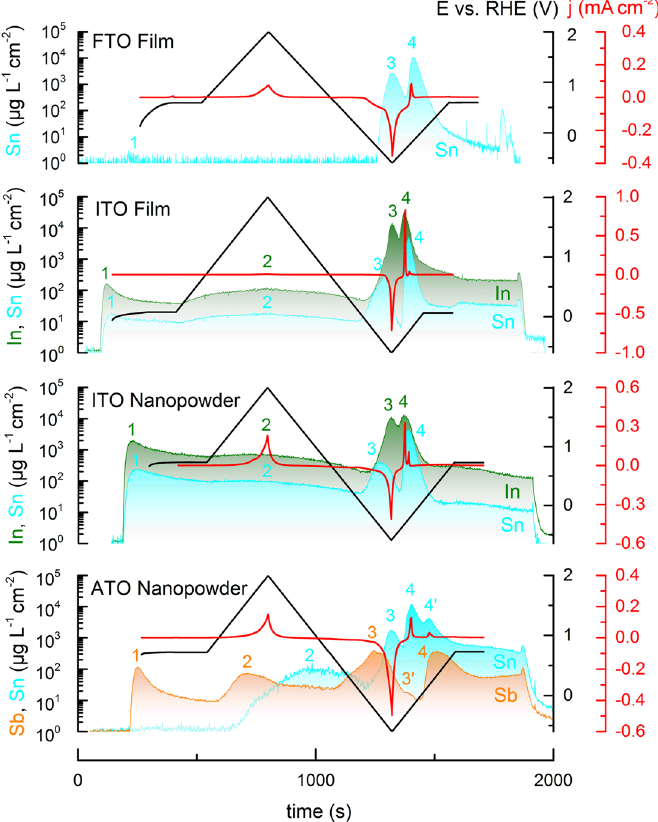
Figure 1. Corrosion of FTO, ITO and ATO studied by tracking the metal concentration in the electrolyte at open circuit potential and during a slow scan (5 mV s − 1 ) to anodic and cathodic region in 0.1 M H 2 SO 4 purged with